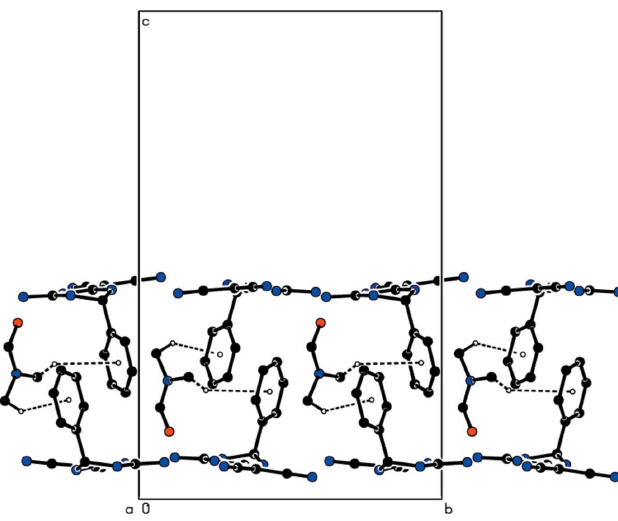
Figure 5 A partial view down the a axis of the C—H (cid:2)(cid:2)(cid:2) (cid:2) interactions (dashed lines) in the title compound. The minor disordered components and hydrogen atoms not involved in hydrogen bonding have been omitted for clarity.